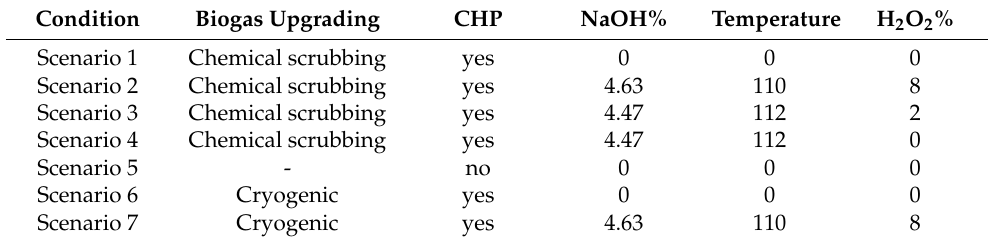
Table 11. Conditions of different